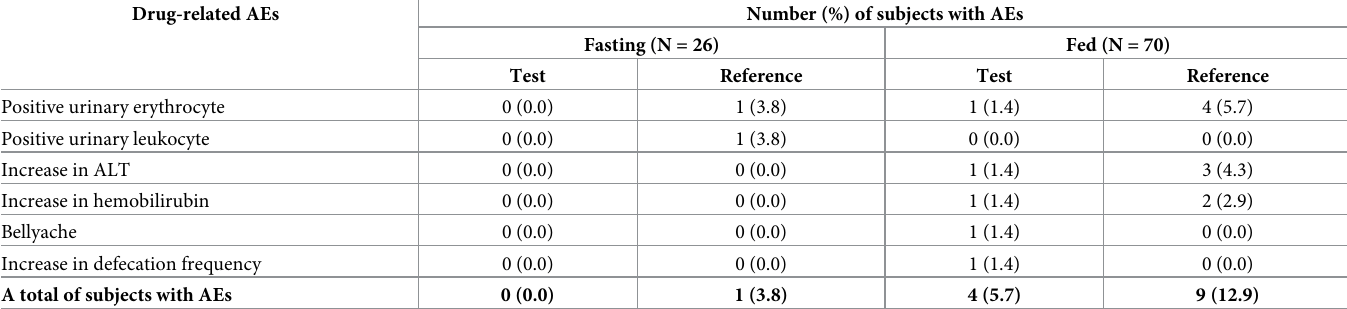
Table 2. All drug-related AEs of test and reference products of calcium dobesilate capsules after single-dose oral administration under fasting and fed conditions in healthy Chinese volunteers.